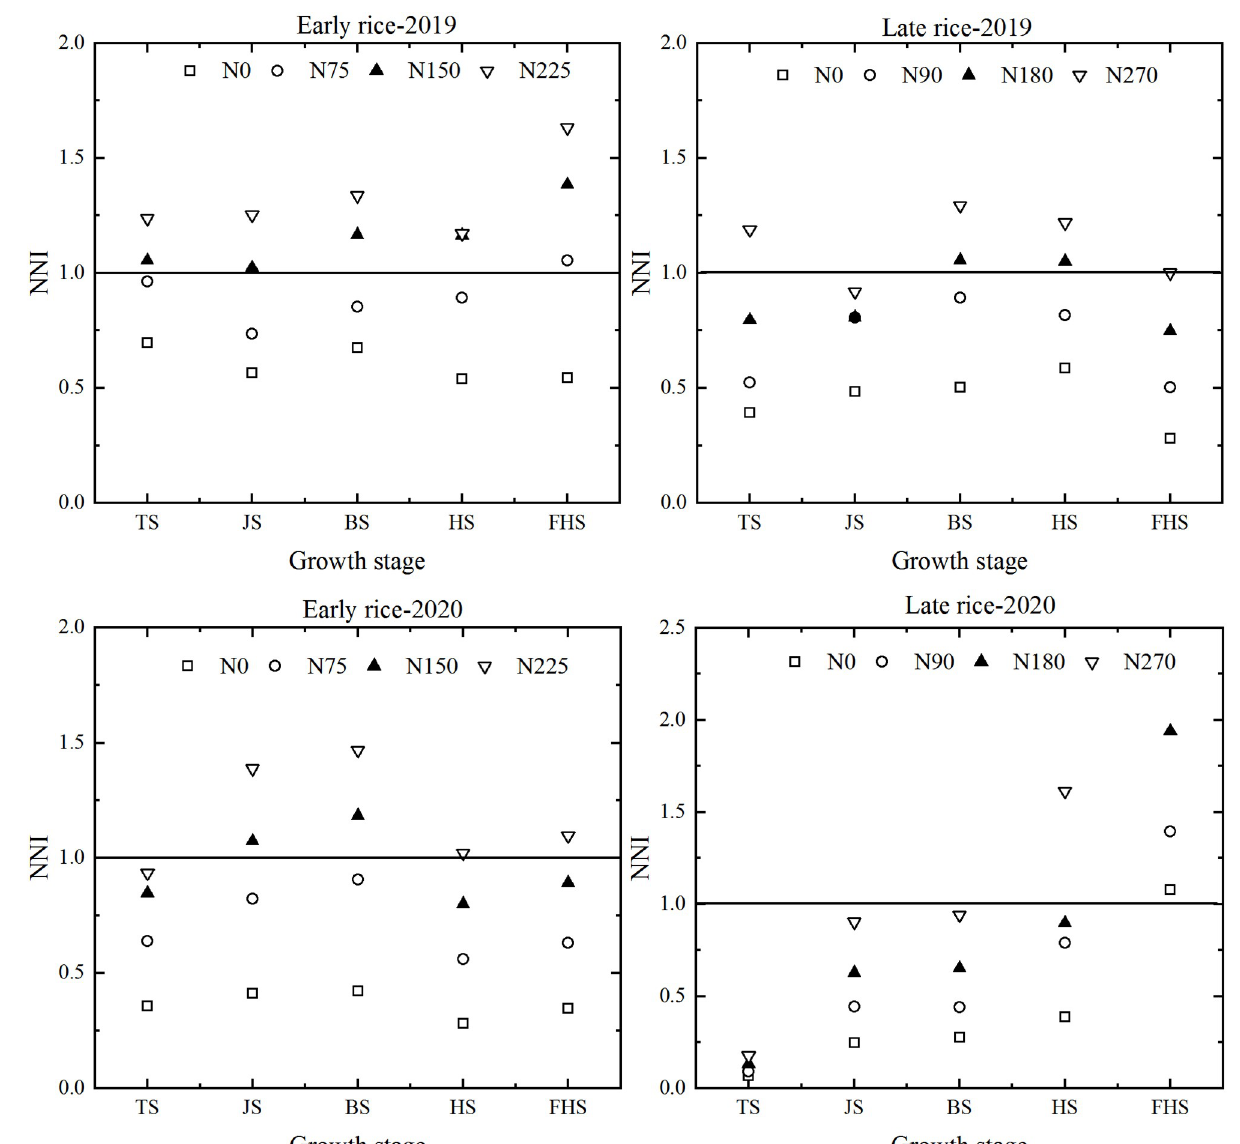
Fig 4. Dynamic changes in the nitrogen nutrition index of rice under different nitrogen application